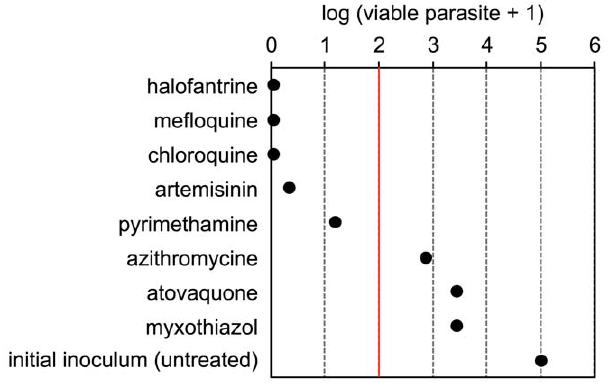
Figure 6. Parasite viability correlates with the mode-of-action of antimalarials. P. falciparum viability time-course profiles for artemisinin, atovaquone, GW648495, and GW844520 measured at 0, 24, 48, 72, 96, and 120 hours. Artemether and artesunate have been investigated at 24 hours only. Error bars are SEM of at least 4 independent experiments.